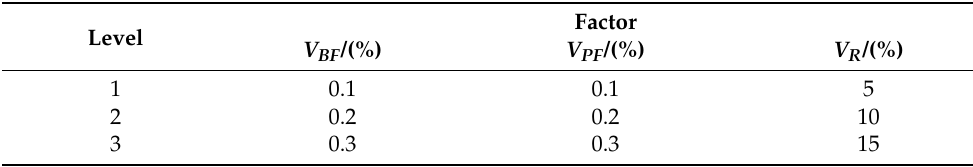
Table 2. Factors and levels table.